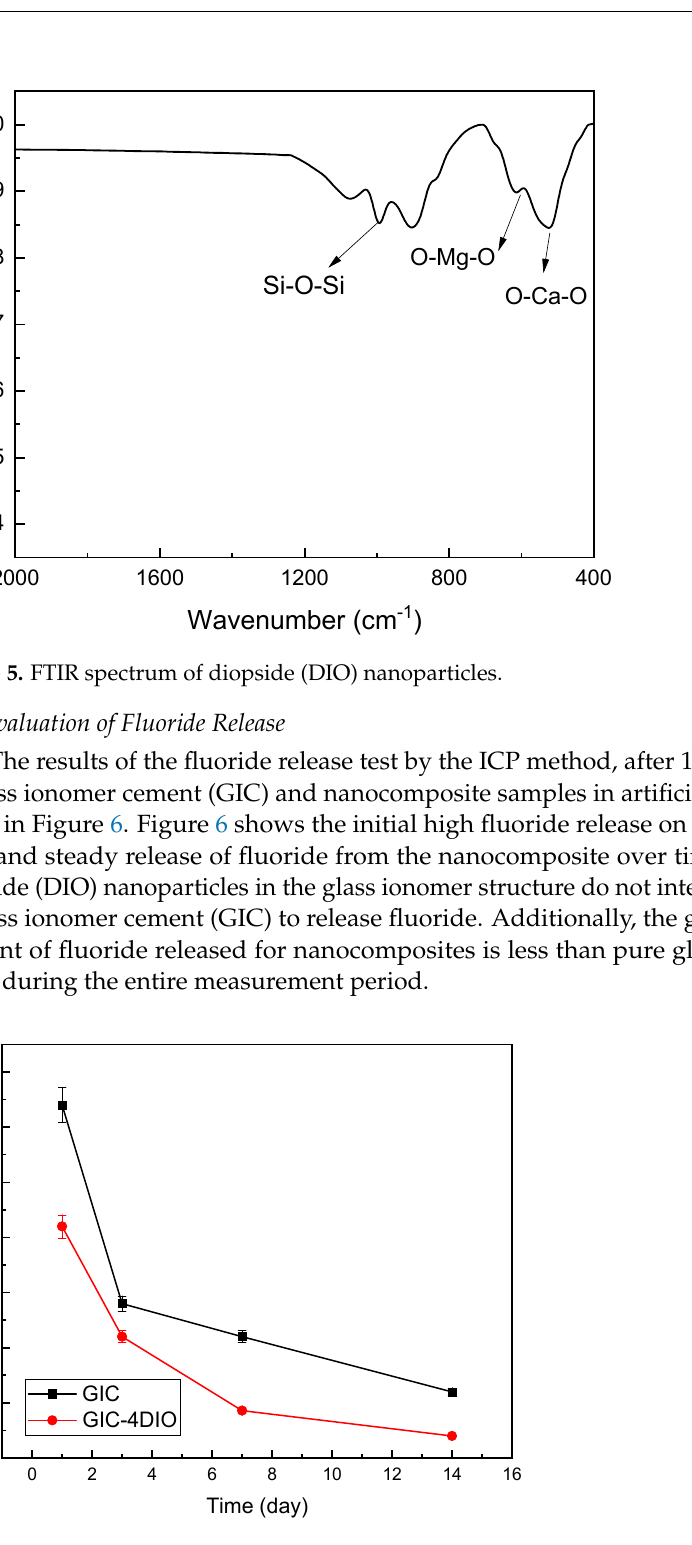
Figure 6. Amount of fluoride released from glass ionomer cement (GIC) and glass ionomer cement (GIC)-4 diopside (DIO) nanocomposite for 14 days immersion in artificial saliva.